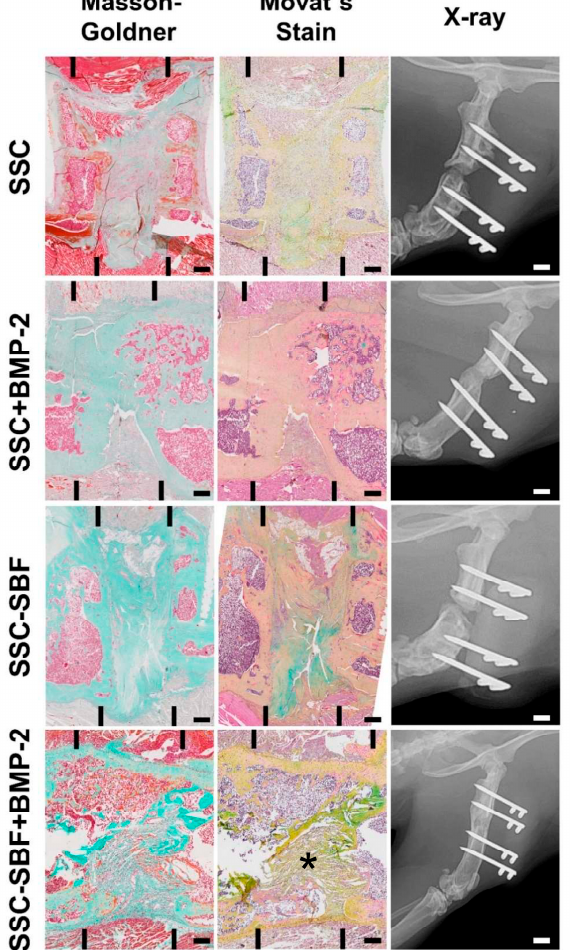
Figure 6. Representative histological sections of the defect area for all treatment groups stained either with Masson–Goldner trichrome ( left ) or Movat’s pentachrome ( middle ) stain. The margins of the original defect are indicated by black bars (Scale bar = 1 mm). The right column shows X-rays of the same samples in a lateral plane 10 weeks postoperatively with the internal fixator still in place (Scale bar = 4.5 mm). * remnants of silk fibroin scaffold.